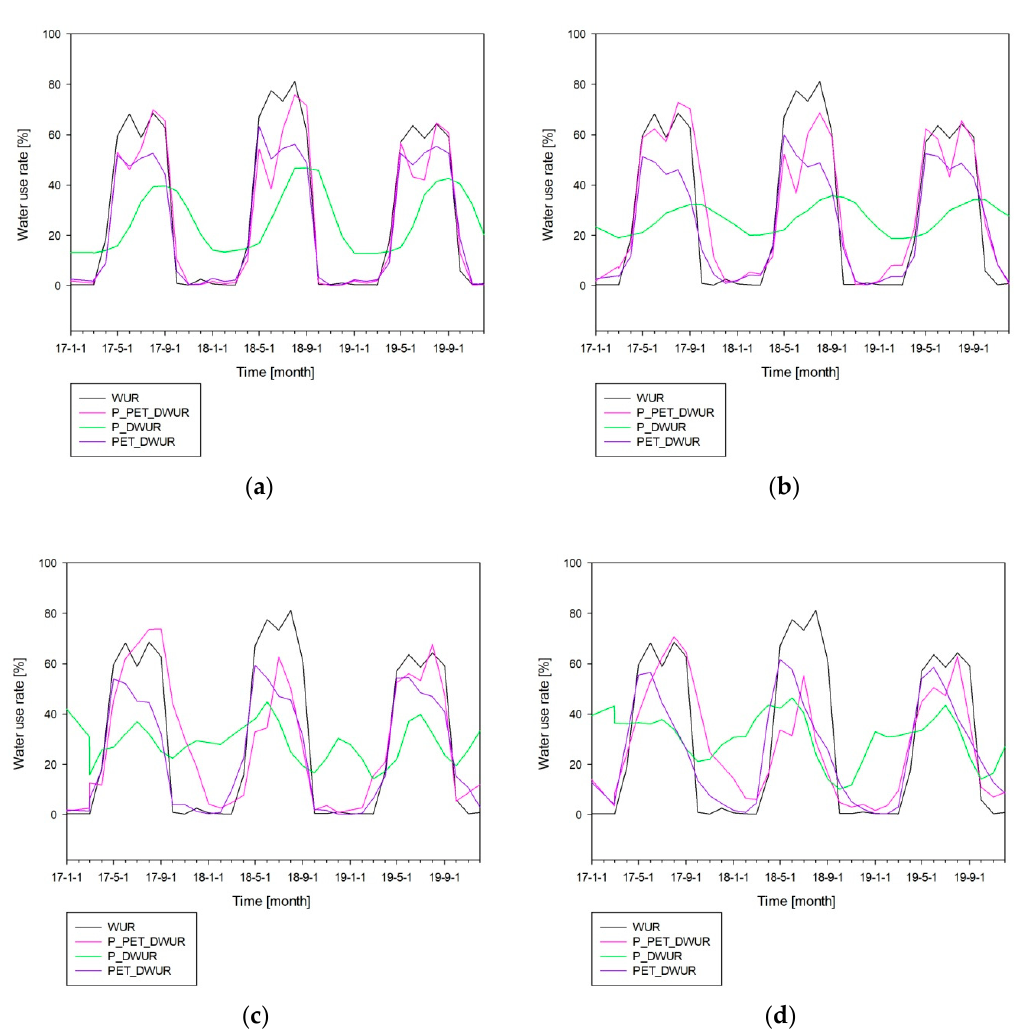
Figure 7. Comparison between the observed and estimated stream water-use rate in the validation period. ( a ) 3-month cumulative; ( b ) 4-month cumulative; ( c ) 5-month cumulative; ( d ) 6-month cumulative.